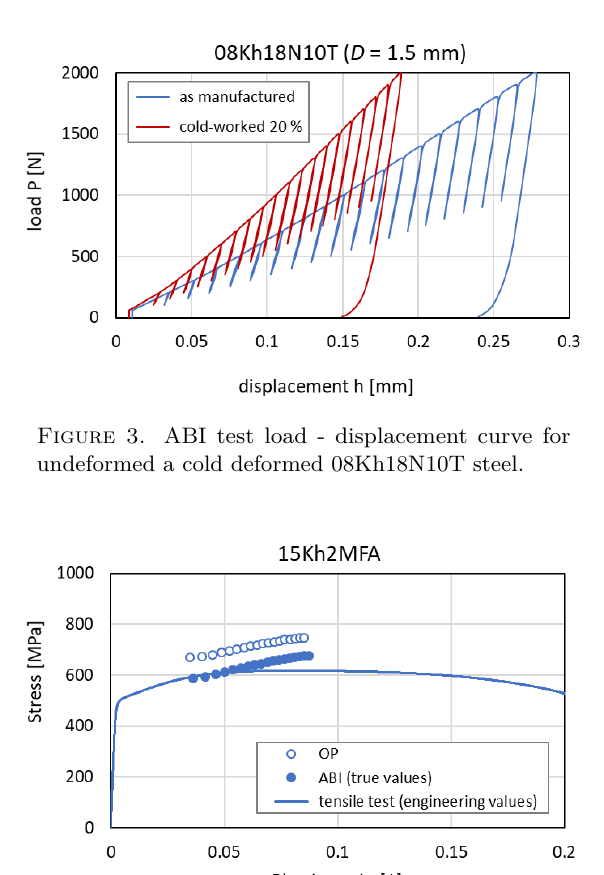
Figure 5. True stress/plastic strain curves for Sv 08Kh19N10G2B steel obtained by various tech- niques.